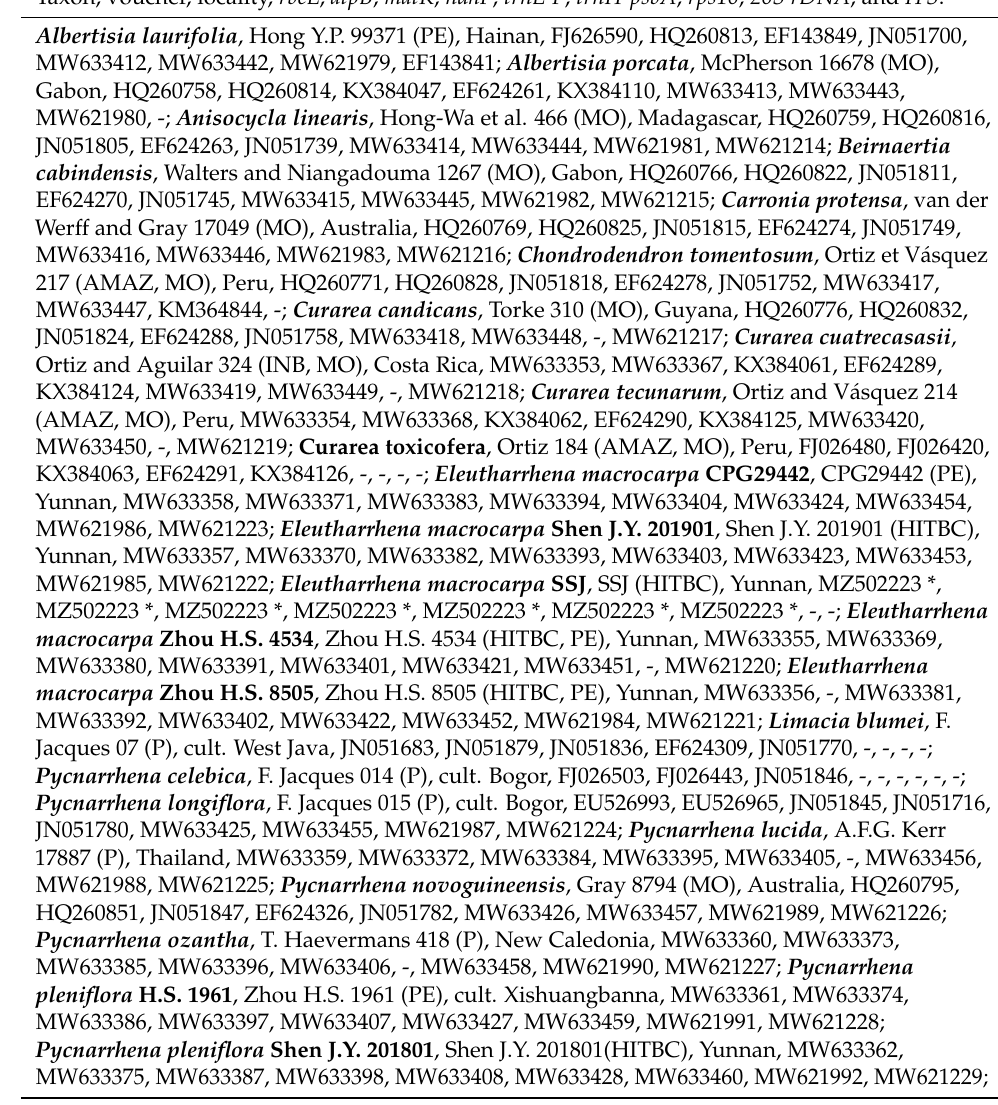
Table A2. DNA sequences used for maximum likelihood and Bayesian phylogenetic analyses (new sequences are labeled with an asterisk